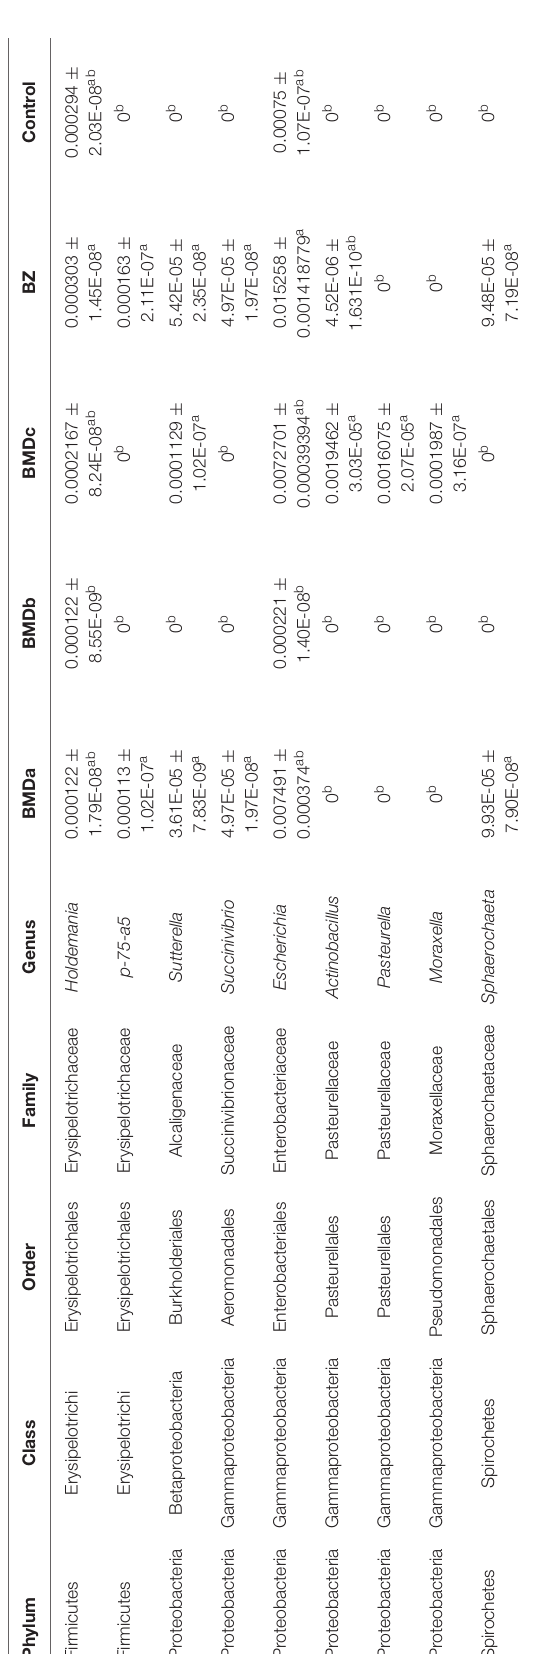
Supplementary Figure 1 | Non-metric multidimensional scaling analysis based on OTUs. Each point in the graph indicates a sample, and the distance between the points indicates the degree of difference. The same group of samples is shown in the same color. Supplementary Table 1 | Ingredient composition and nutrient levels of the basal diets. Supplementary Table 2 | Primers used for real-time qRT-PCR. Supplementary Table 3 | Differential analysis among groups using MRPP. The smaller the observed-delta value, the smaller the difference within the group;